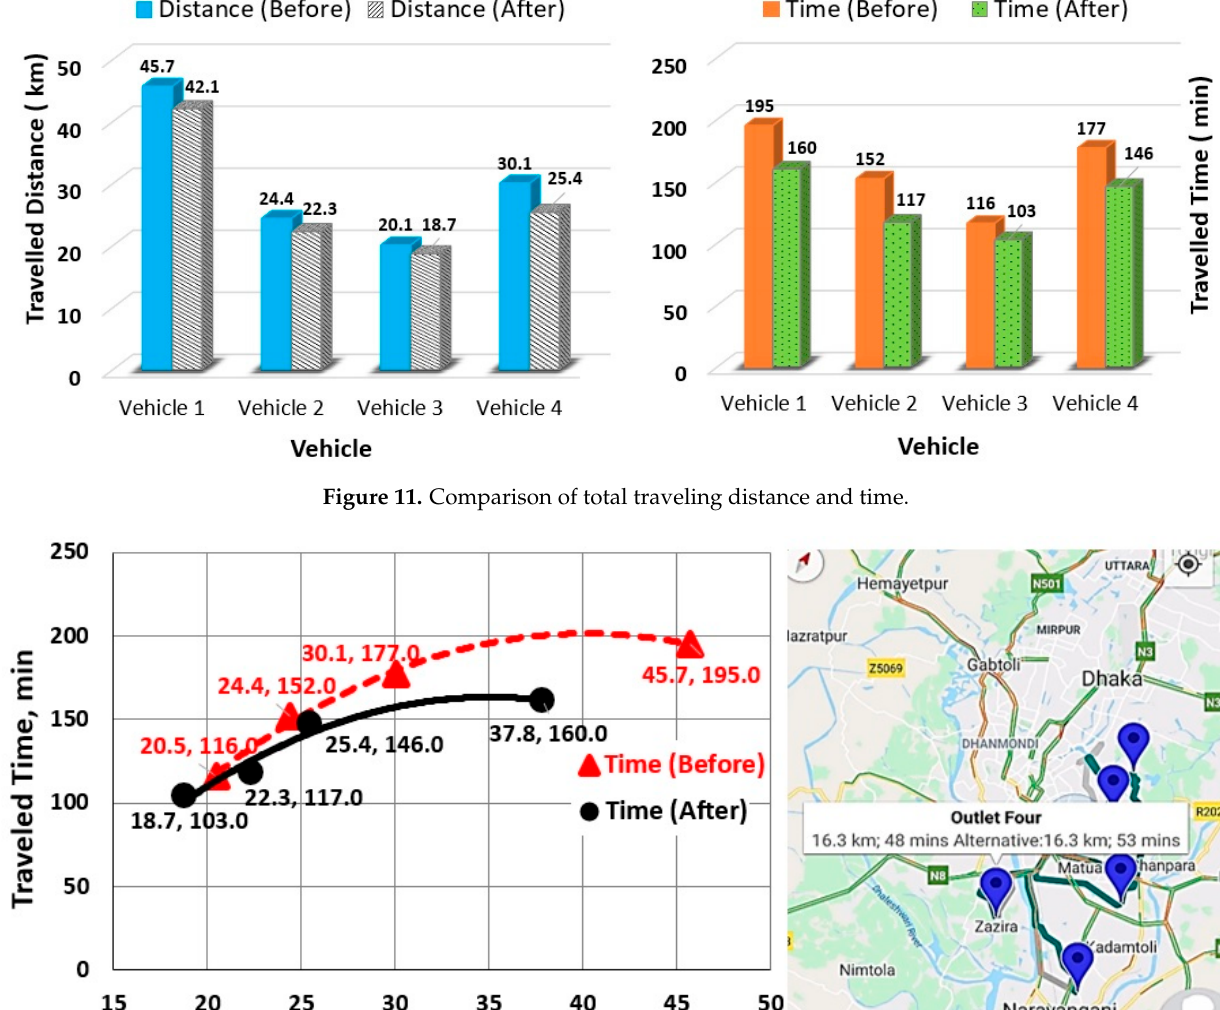
Figure 13. Percent reductions of distance and time for ( a ) each individual vehicle; ( b ) each region. Additionally, percent reduction data of distance and time for Region 1 and Region 2, shown in Figure 13b, suggests a substantial improvement in each region before and after using the intelligent routing optimizer. The non-proportionality relationship between per- cent reduction of distance and time is observed in Figure 13. This could be due to the inclusion of non-driving time into the total travel time arising from the influence of traffic obstacles, traffic signals, and jams in the Dhaka city road network [58]. Moreover, higher values of the percent reduction in Region 1 than in Region 2 support the effect of new and